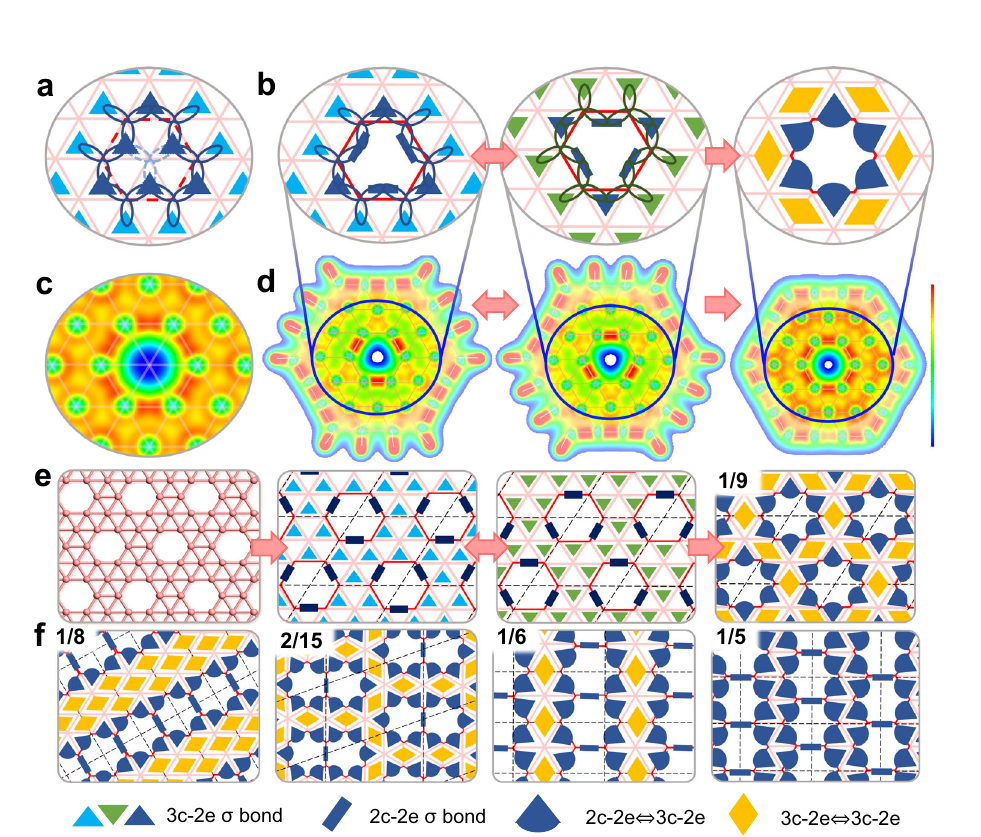
density (VECD) mapof the perfecttriangularboron sheet shows the delocalization of 3c-2e σ bonds in the sheet plane. The intensity scale bar is from 0.02 to 0.15 e/ Bohr 3 (blue to red). c-f σ bonding con fi gurations of ( c ) B 6 H 9 3- , ( f ) B 6 H 3 clusters based on our analysis, and ( d , e ) the VECD maps of them in the boron plane. The intensity scale bar is from 0.02 to 0.165 e/Bohr 3 (blue to red).